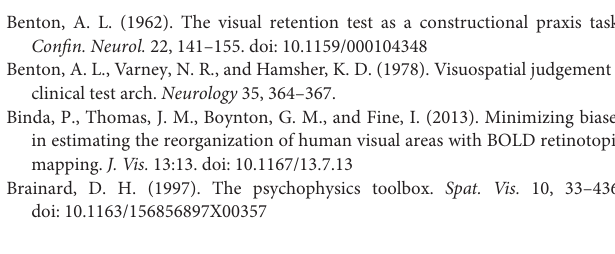
FIGURE S1 | Example sagittal slices from CW’s high resolution T1 scan. For the figure, we have used the most recent T1 (second MRI session) after skull stripping only. Top rows correspond to the left and bottom rows to the right hemisphere as indicated by the x coordinate ( x : − 35.5 to 37.5, y : 14.85, z : 35) shown underneath the volumes. FIGURE S2 | Response amplitude ( β ) estimates for the right hemisphere plotted against eccentricity for the ventral and dorsal early visual areas. Red color corresponds to CW, black color, to the three controls. Symbols denote the mean in each eccentricity band. Error bars denote 1 standard error of the mean. FIGURE S3 | Control pRF analysis, maps for polar angle. When the portion of the visual field corresponding CW’s scotoma was masked out, maps in all the visual areas for both CW and a healthy control participant were unsurprisingly severely distorted, possibly with the exception of the ventral left visual cortex corresponding to the part where the stimulus remained visible. FIGURE S4 | CW’s Gray (A) and White (B) matter images from the segmented T1s at 96 months (1) and 53 months (2). TABLE S1 | Whole brain and occipital lobe grey matter (GM) and white matter (WM) volumes. Mean and standard deviation was calculated based on the tissue volumes of the healthy controls using the Dartel modulated segmented images. TABLE S2 | Whole brain grey matter (GM) and white matter (WM) volumes of the original segmented images after controlling for total intracranial volume (calculated as the sum of GM, WM and Cerebrospinal